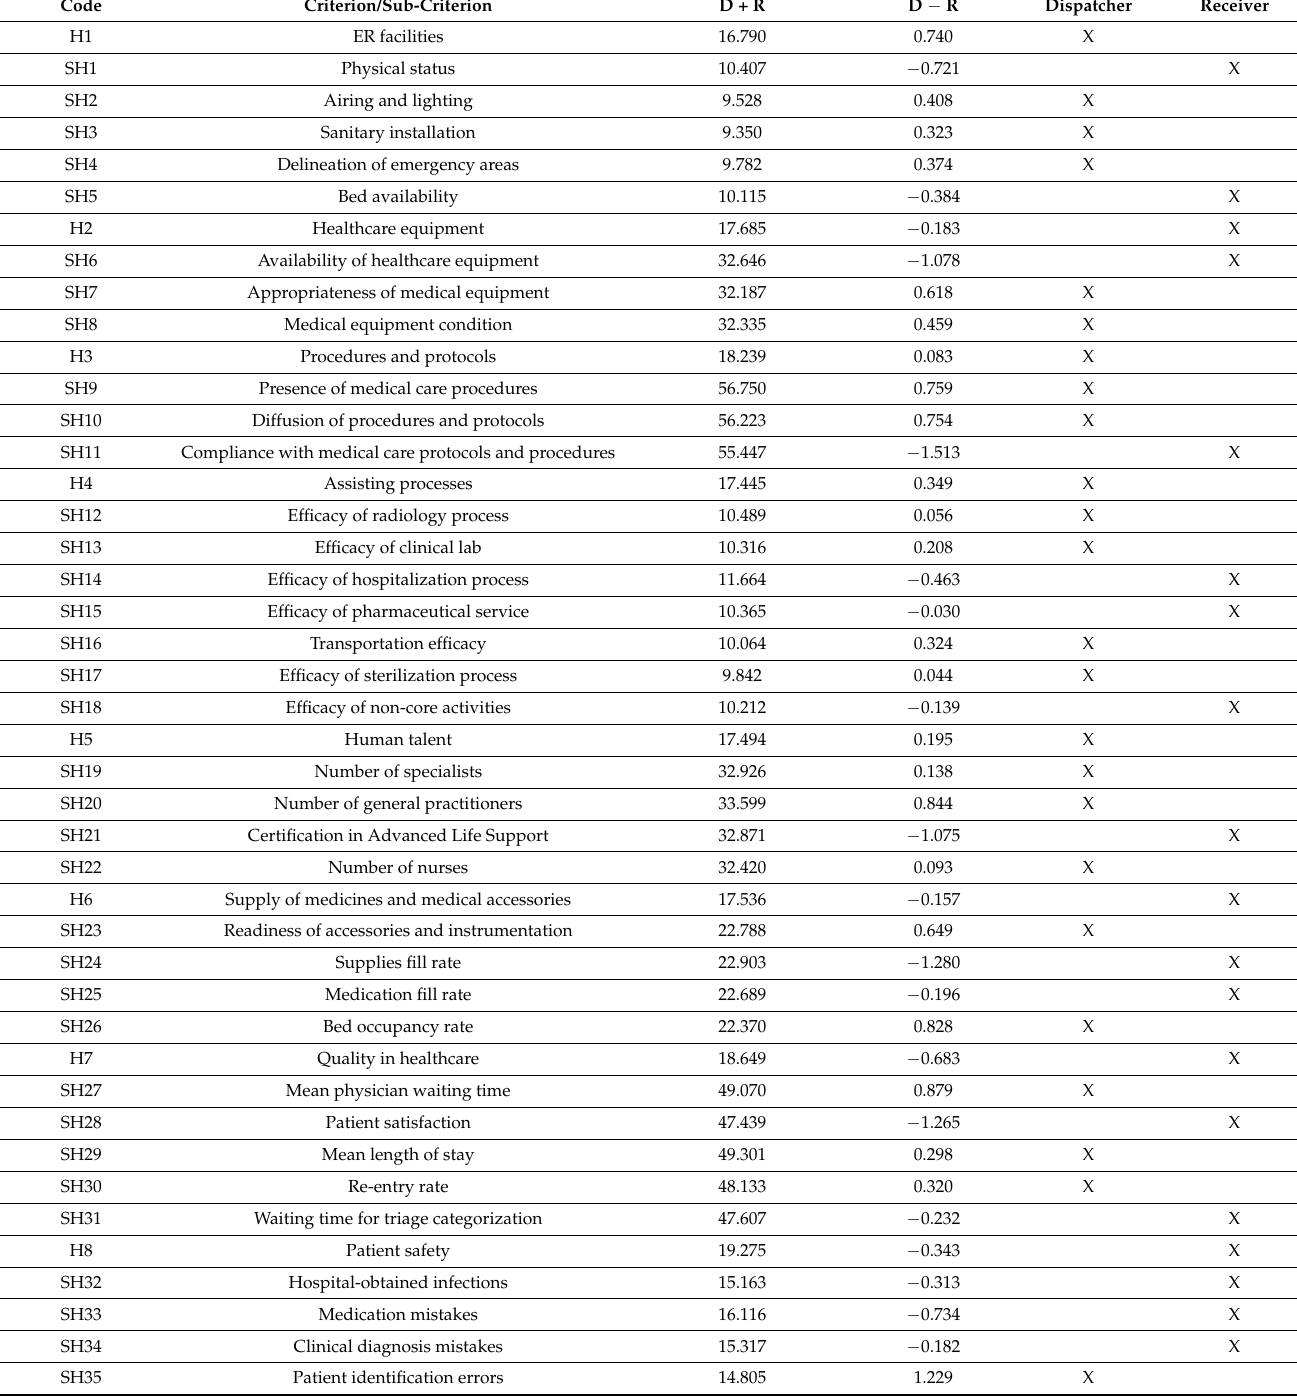
Table 11. Dispatchers and receivers in the ED performance evaluation model—COVID-19